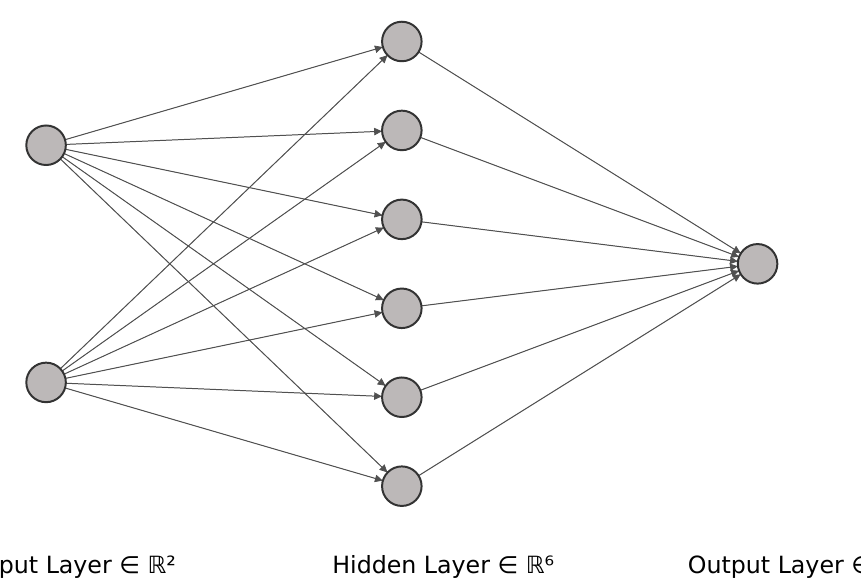
Figure 6. Layout of ANN used to estimate microgrid equivalent n p